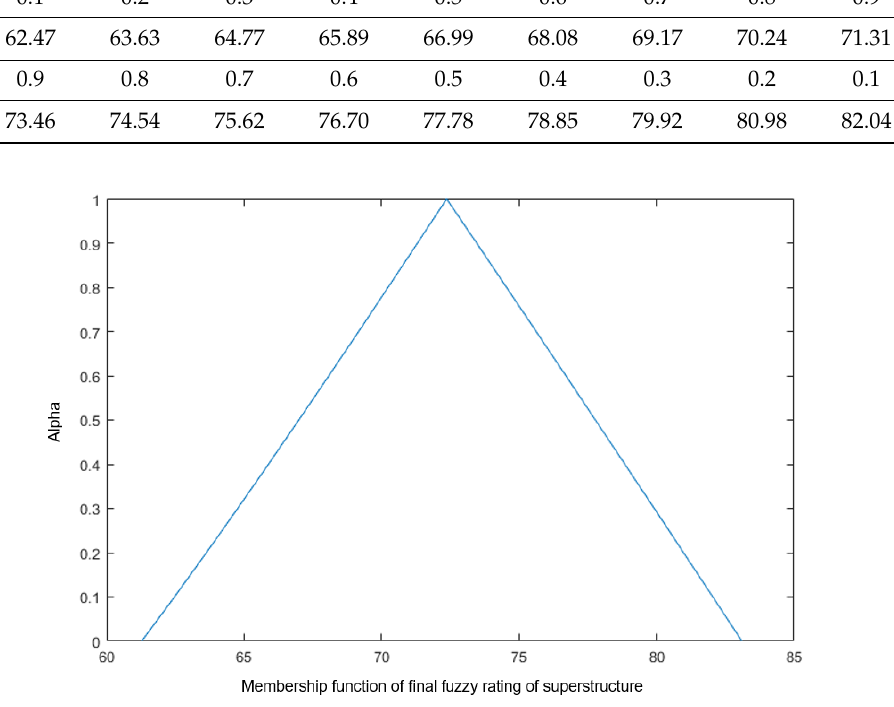
Figure 7. Graphical representation of the membership function of superstructure component final rating for all combinations.